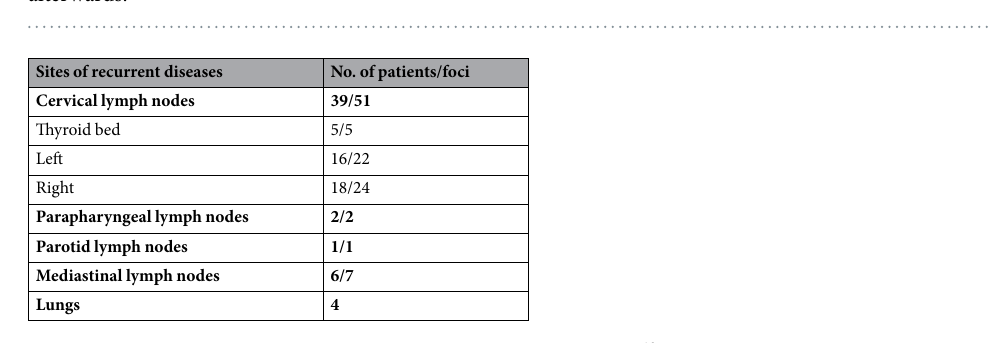
Table 2. Sites for recurrent diseases in 54 patients with true-positive 18 F-FDG PET/CT